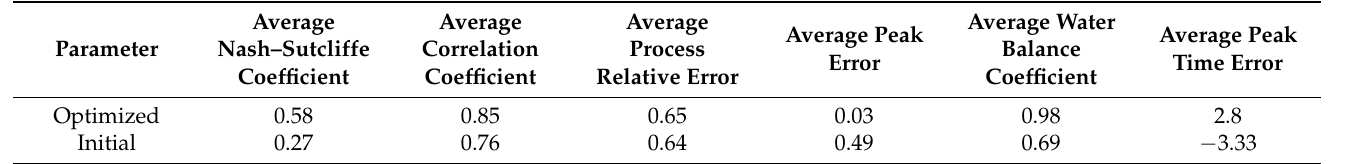
Table 5. Statistical indicators of the flood simulation results before and after parameter optimization.